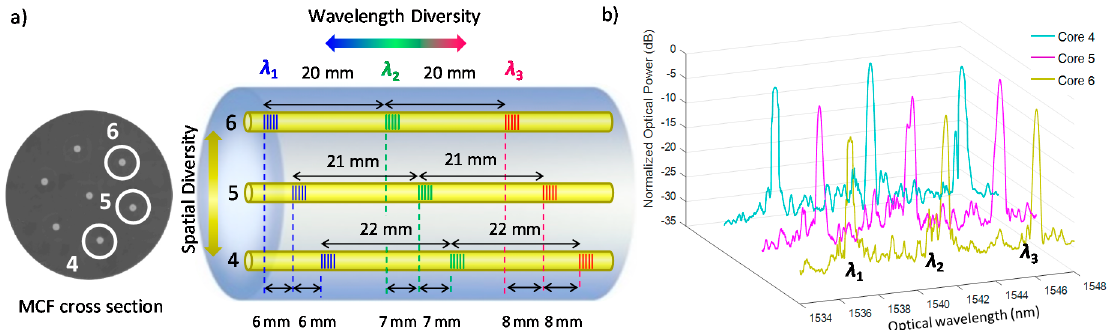
Figure 6. ( a ) Schematic of the multicavity device built by selectively inscribing fiber Bragg gratings in three of the outer cores of the commercial homogeneous seven-core fiber; and ( b ) corresponding measured optical spectrum in reflection [51].